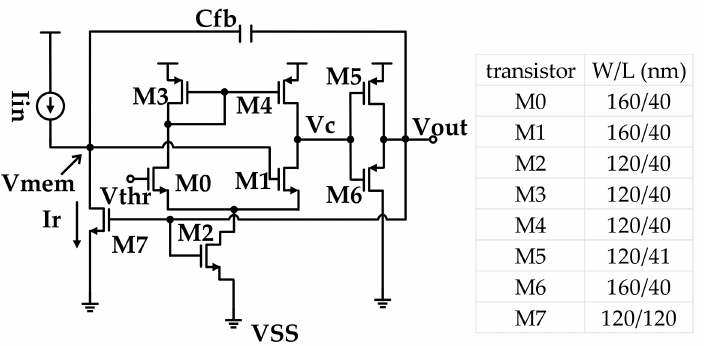
Figure 7. Schematic diagram of the designed circuit, with the information of the sizes of the